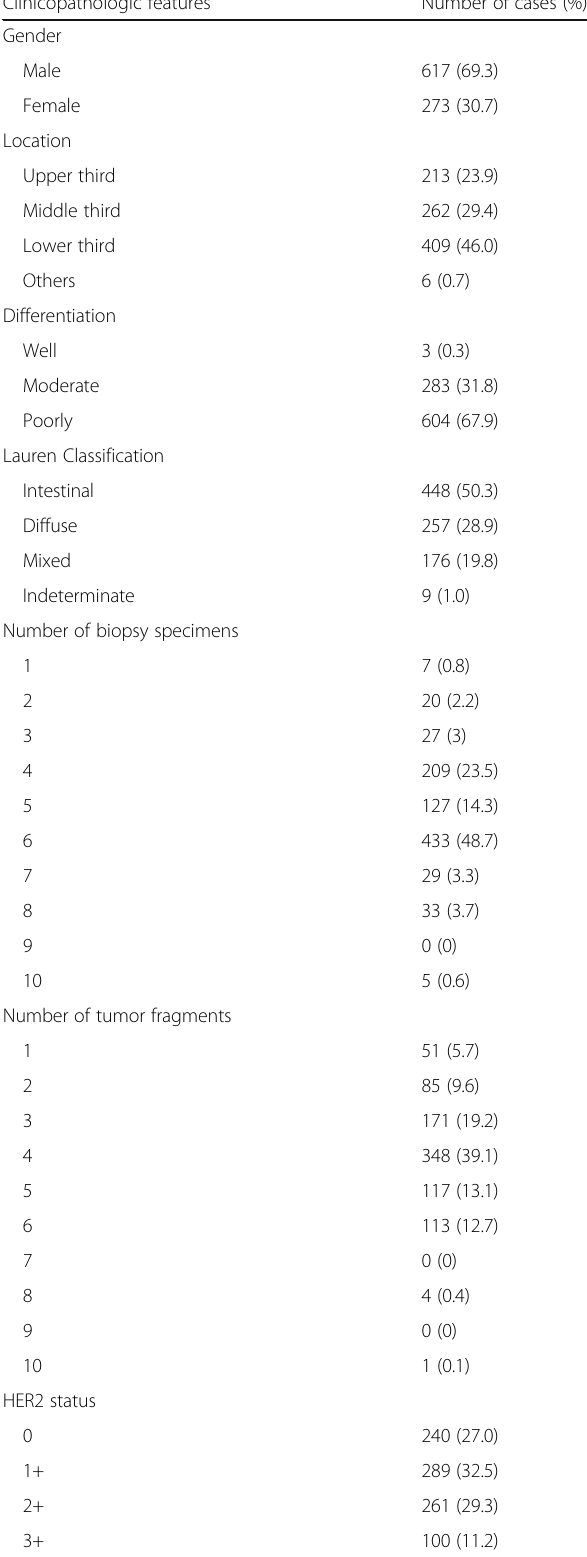
Table 1 Clinicopathologic features of the patients Clinicopathologic